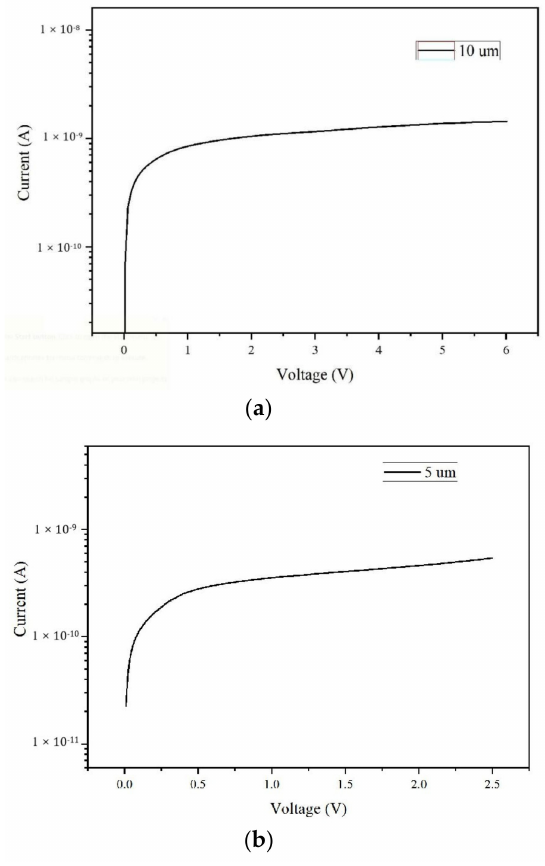
Figure 10. Leakage current curves (log scale) vs. bias voltage for detectors with electrode spacings of ( a ) 10 µ m and ( b ) 5 µ